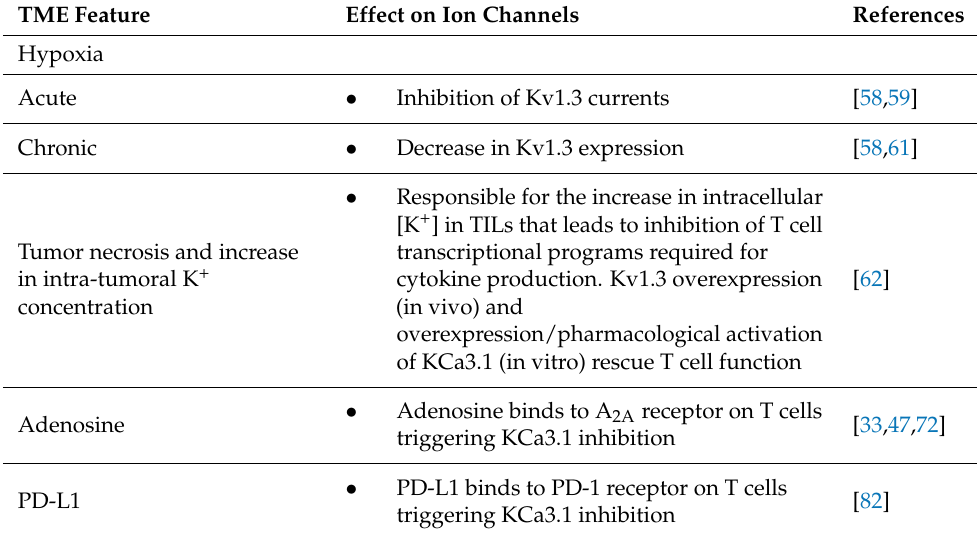
Table 1. Effects of the tumor microenvironment (TME) characteristics on K + channel network of T cells. Abbreviations: TILs, tumor-infiltrating lymphocytes; PD-L1, programmed cell death ligand 1; PD-1, programmed cell death